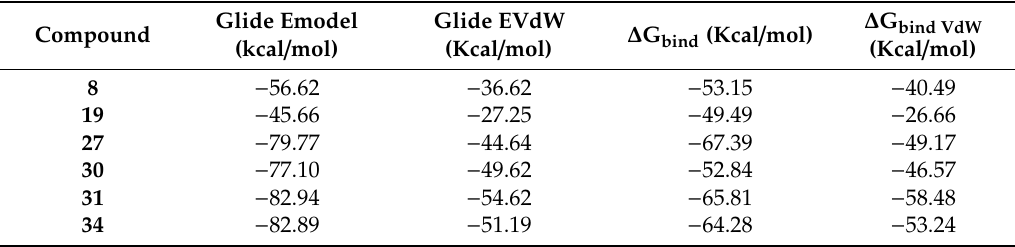
Table 11. Predicted Glide SP score values obtained from molecular docking for selected compounds 8, 19, 27, 30, 31, and